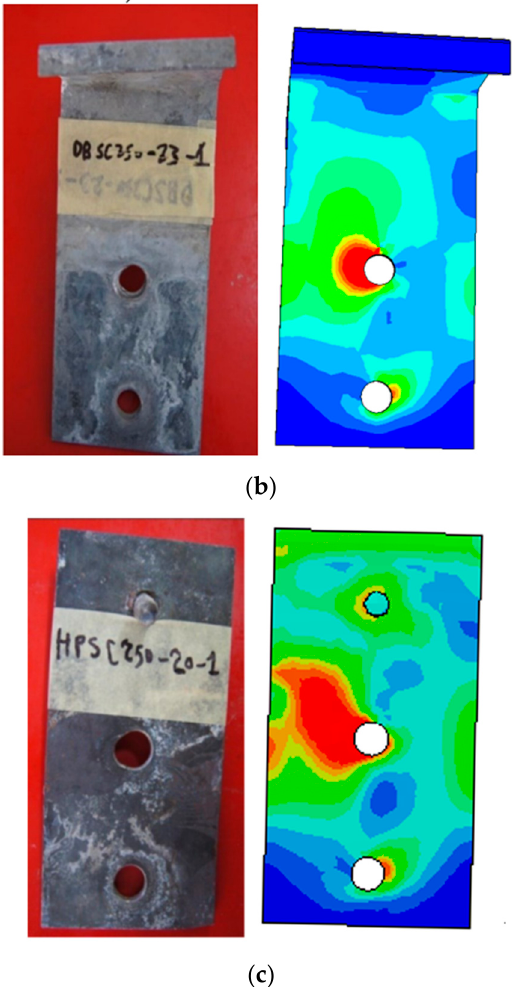
Figure 7. Comparison of deformed shear connectors from the FE model and push test specimens. ( a ) SBSC Shear Connector. ( b ) DBSC Shear Connector. ( c ) HPSC Shear Connector.